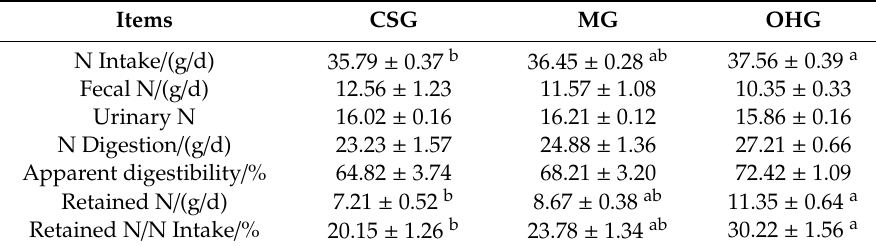
Table 5. E ff ects of dried oat hay content in diet on N apparent digestibility of sheep. Items